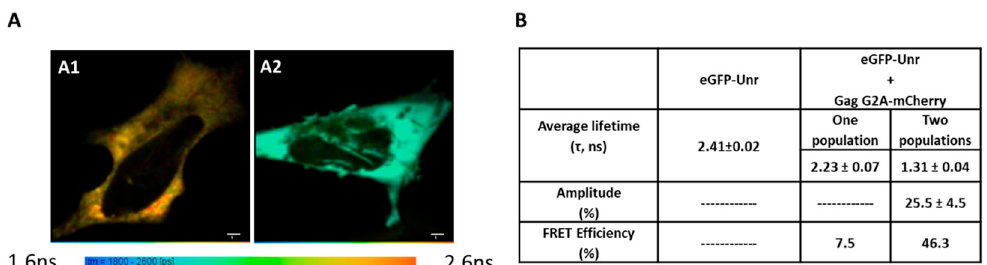
Figure 7. Unr/GagG2A interaction monitored by FRET-FLIM. HeLa cells were transfected with DNA constructs encoding eGFP-Unr in the absence ( A1 ) and the presence of GagG2A-mCherry ( A2 ). Live cells were imaged 24 h post-transfection. The eGFP fluorescence lifetimes were determined using a single-exponential model and converted into a color code ranging from blue (1.6 ns) to red (2.4 ns). ( B ) Fluorescence lifetimes of eGFP-Unr, in the presence of GagG2A-mCherry, were analyzed by one or two populations analysis. The lifetimes are expressed as mean ± SEM for about 20 cells. For the two populations analysis, the long lifetime was fixed to 2.41 ns, and the shorter lifetime as well as its amplitude were determined and expressed as mean ± SEM for about 20 cells. The bar scale represents 10 μ m.